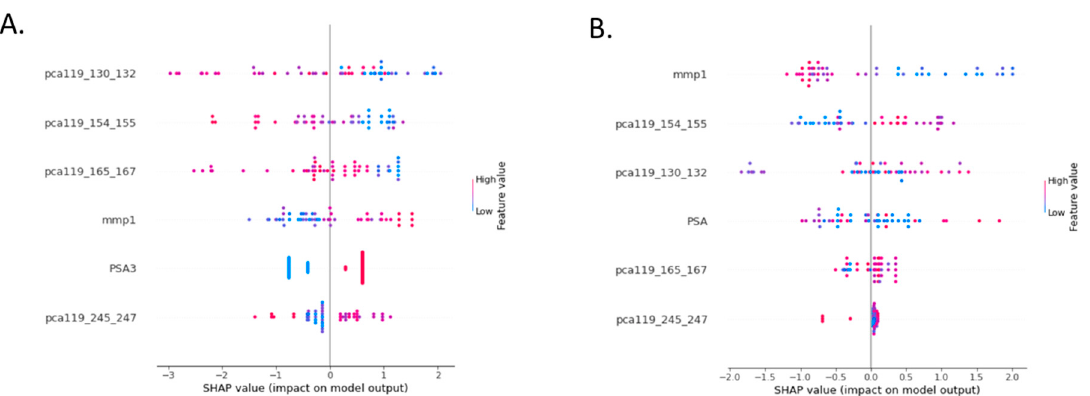
Figure 3 . SHapley Additive exPlanations (SHAP) values of each marker contribution in the PSE model. SHAP values (26) demonstrating the contribution of each marker in the model are shown for the binary PSA ( A ) and continuous PSA ( B ). Each dot represents one